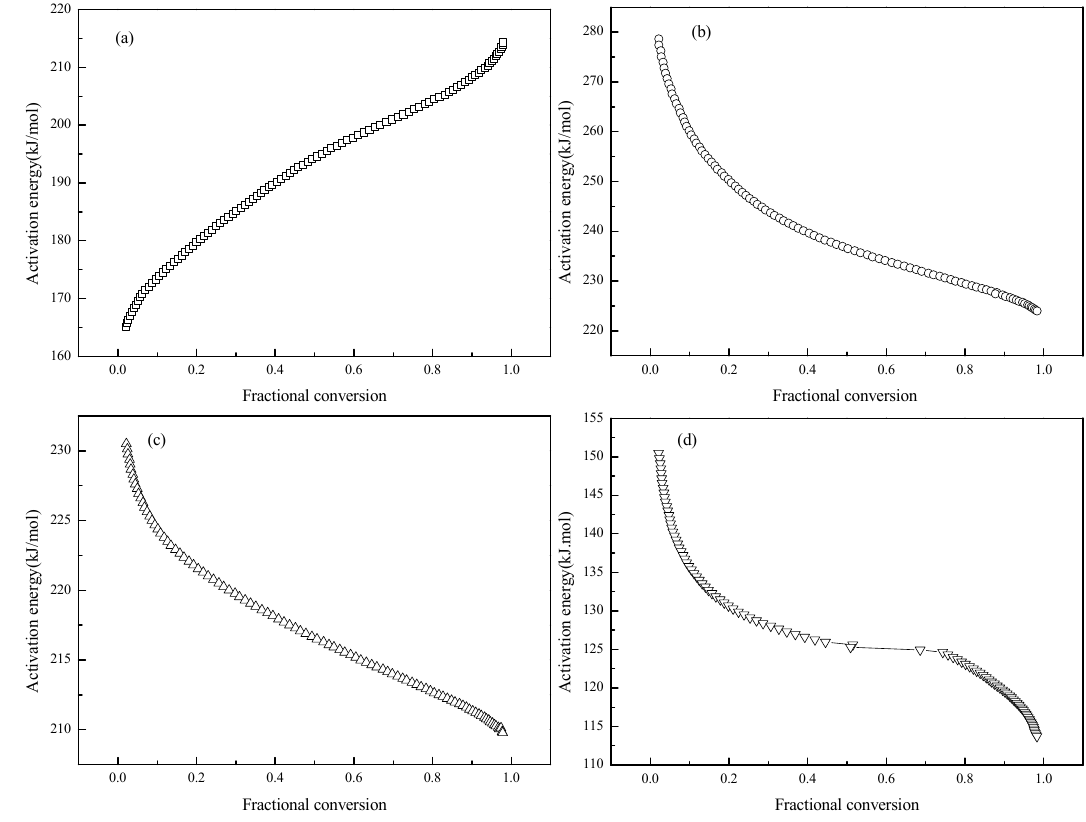
Figure 7. Distributed activation energy curves of samples: ( a ) RD; ( b ) C-1; ( c ) C-2; and ( d ) CC.